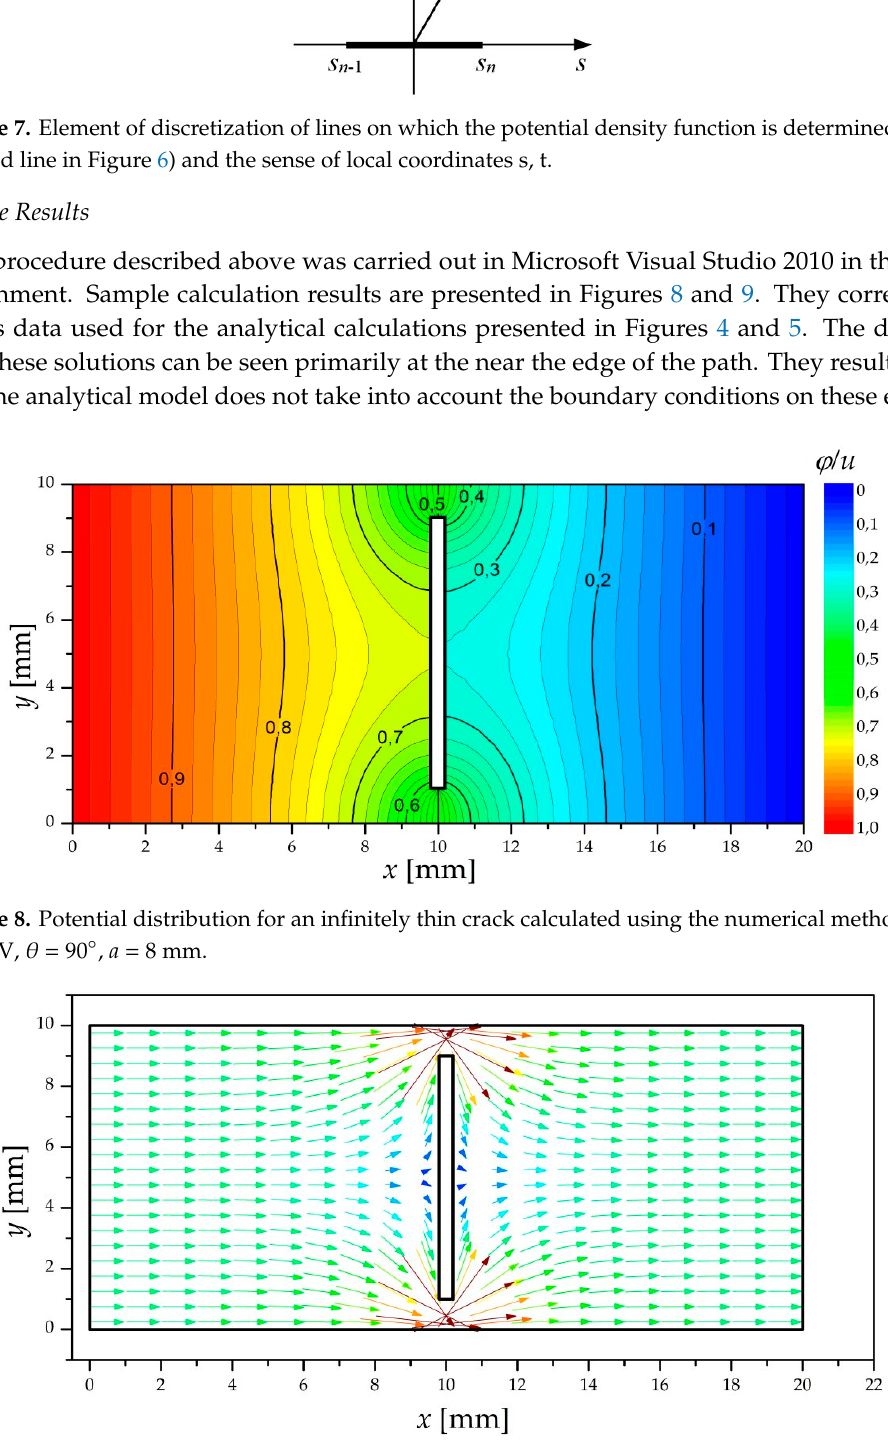
Figure 9. Distribution of the current density vector for an infinitely thin crack calculated by the numerical method for u = 1 V, θ = 90 o , a = 8 mm.